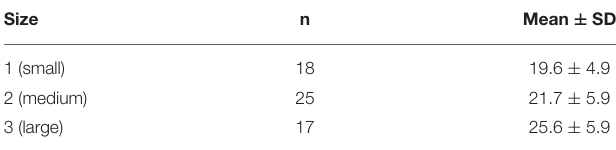
TABLE 4 | Large ovary size in each classified group.